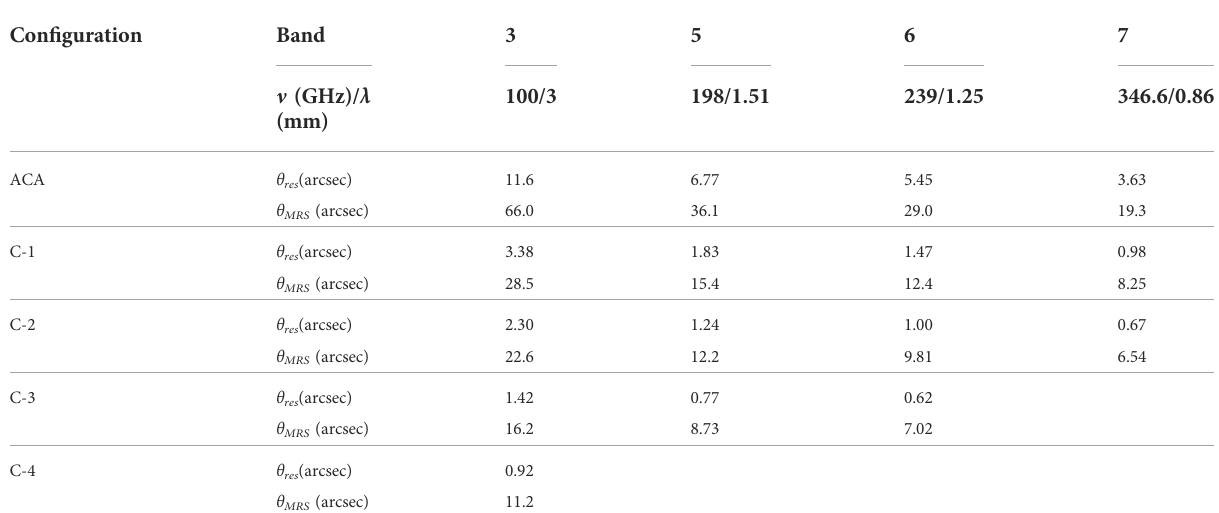
TABLE 2 ALMA angular resolution and maximum recoverable scale.